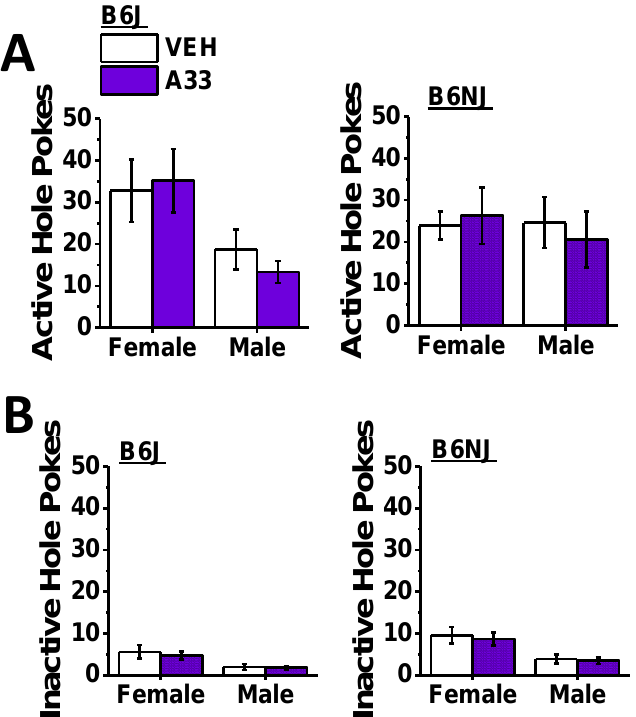
Figure 6. Summary of the effects of A33 pretreatment on cue-elicited responding following a 2-week period of forced abstinence, highlighting no effect of the inhibitor on the number of nose pokes into the active, MA-reinforced hole ( A ) or the inactive, non-reinforced hole ( B ) in B6J (left) and B6NJ mice (right). The data represent the mean ± SEM of 12 mice/sex/substrain.